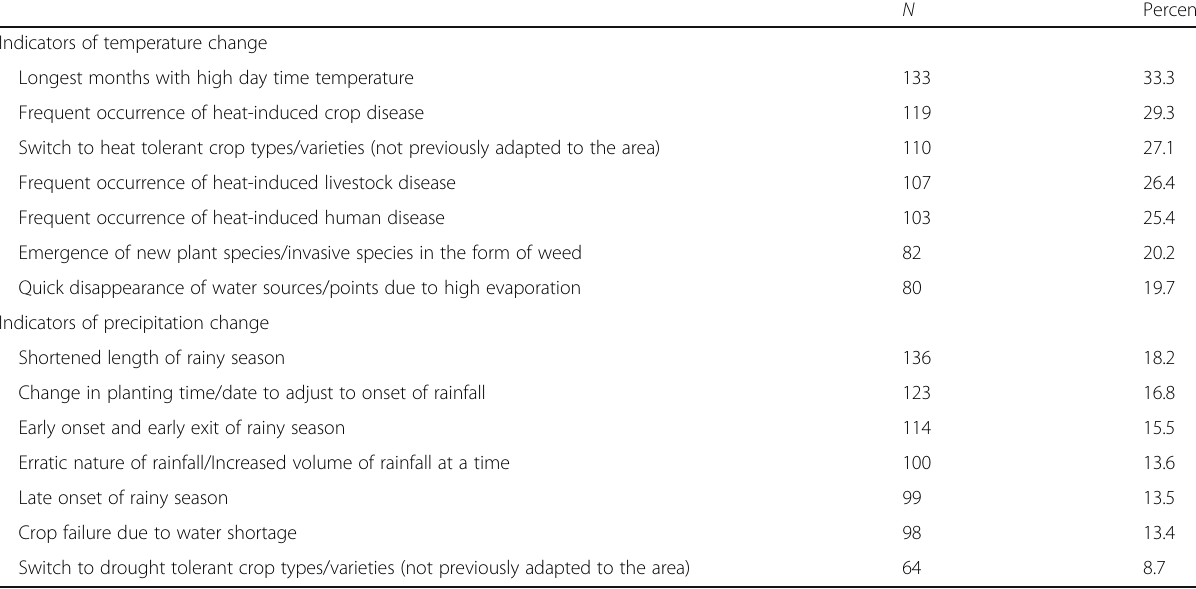
Table 2 Indicators that justify farmers ’ perception of increasing temperature and decreasing precipitation Indicators of temperature change